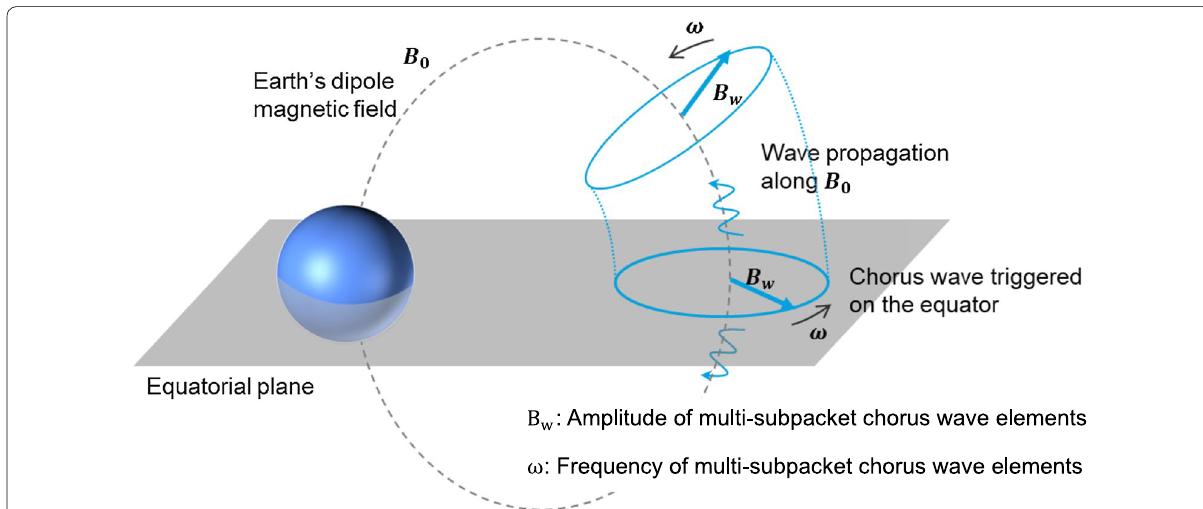
Fig. 1 Schematic illustration of generation and propagation processes of multi-subpacket chorus wave elements. A pair of multi-subpacket chorus wave elements are triggered on the equatorial plane. Each chorus wave element is assumed to propagate northward and southward nearly parallel to Earth’s dipole magnetic field B